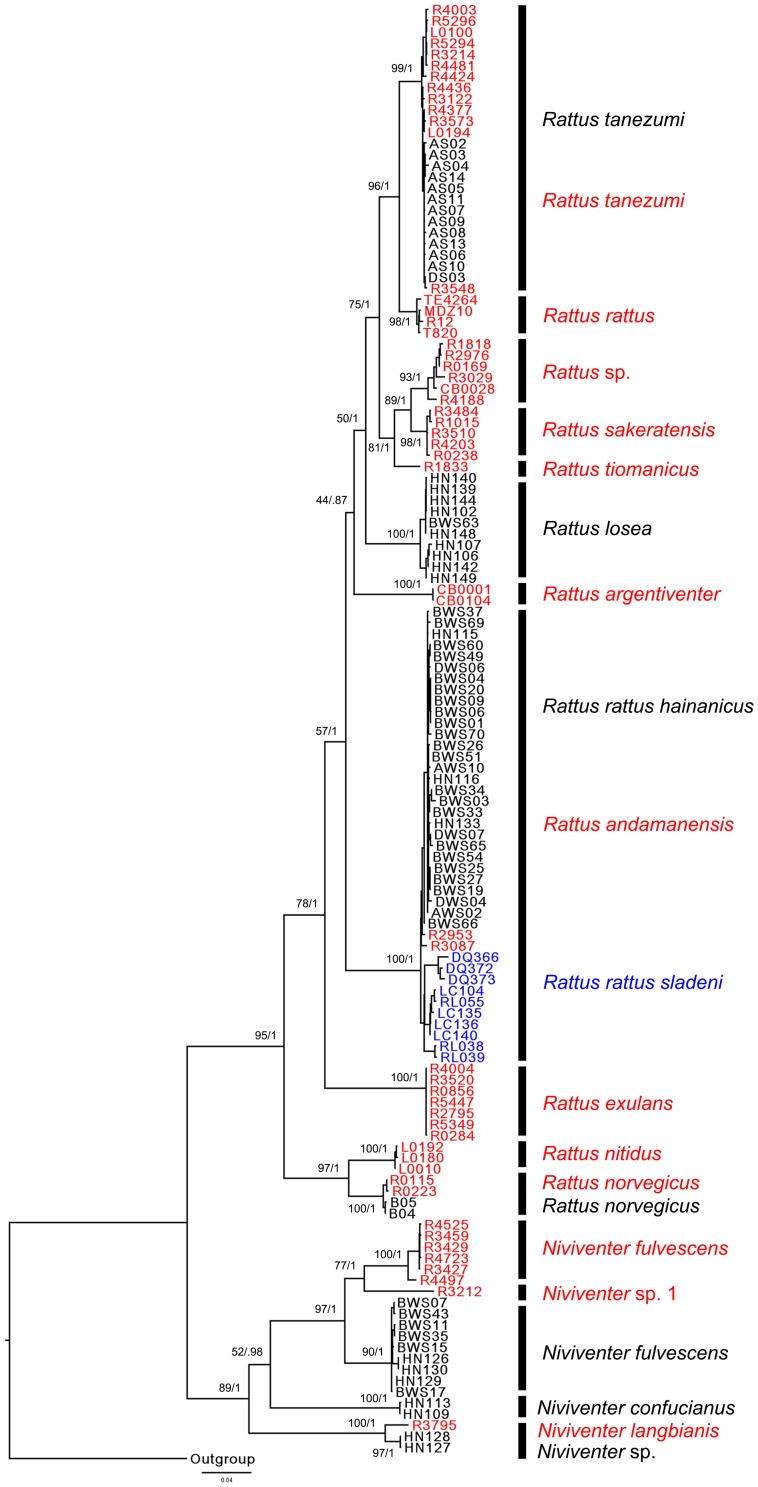
Maximum likelihood tree of Rattus and Niviventer species from Hainan, Yunnan and Southeast Asia based on the combined COI and Cyt-b dataset.ML and BI analyses of the dataset gave identical tree topology. Numbers beside the nodes reflect support obtained from the analysis of the dataset following two different reconstruction methods: ML/BI. The meaning of different colors of samples and lineages names is the same as in the Figure 3.